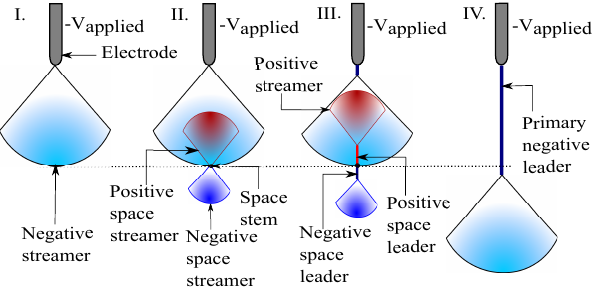
Figure 3. Schematic representation of stages of negative leader